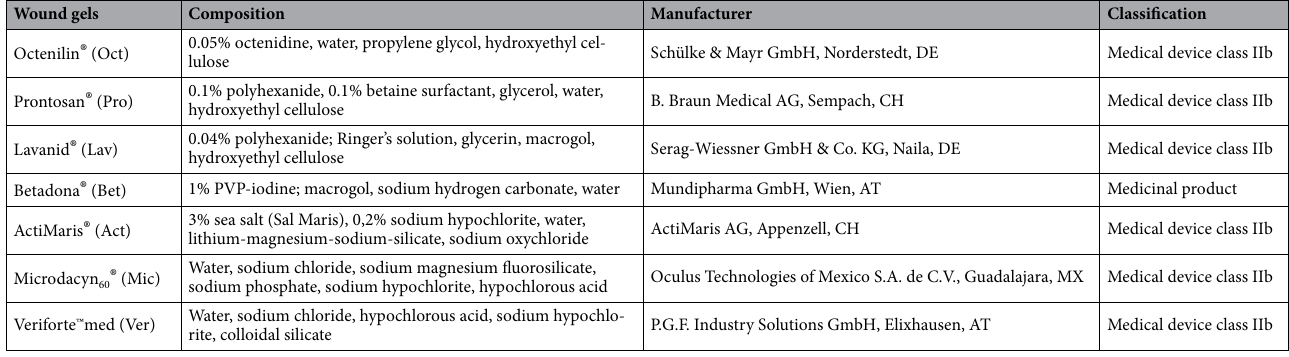
Table 1. Tested commercially available wound